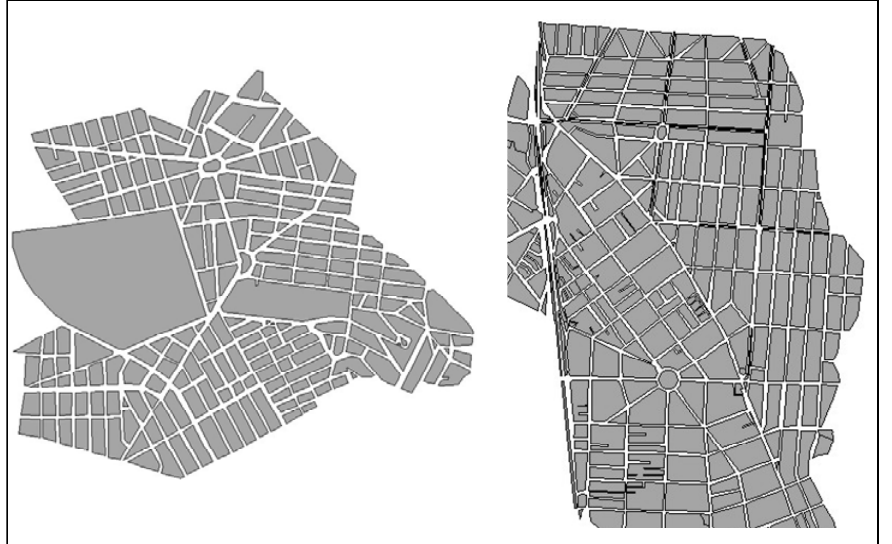
Figure 2. Two examples of irregular road networks in